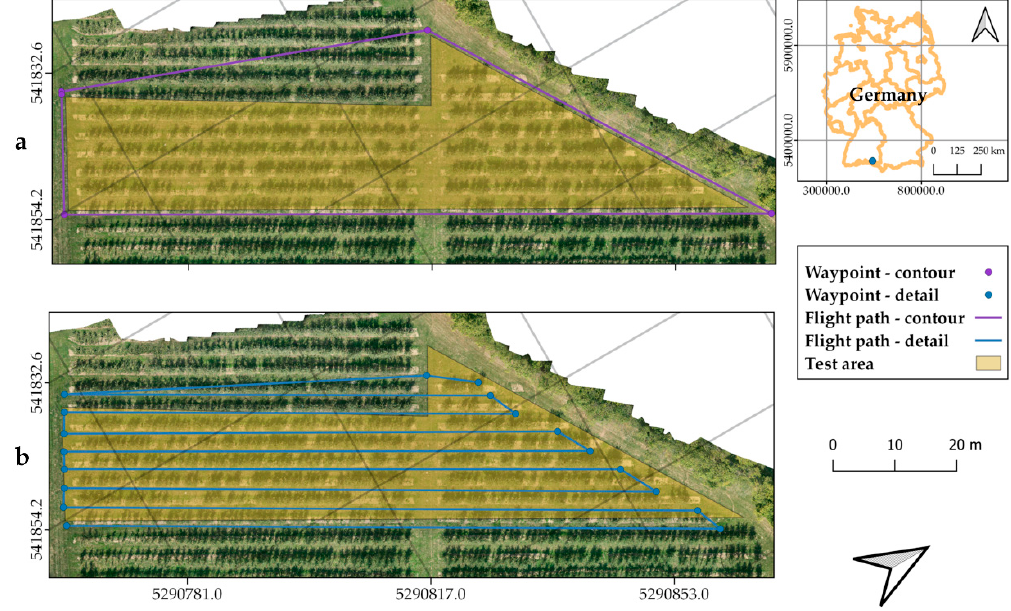
Figure 1. Unmanned aerial vehicle (UAV) flight plan for the test site: ( a ) contour flight and ( b ) detailed flight along the tree rows.